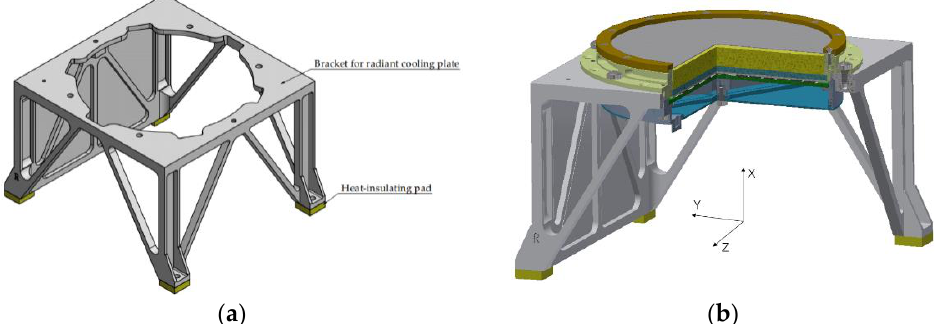
Figure 2. GRM payload: ( a ) Assembly of bracket for radiant cooling plate. ( b ) Assembly of GRM payload.